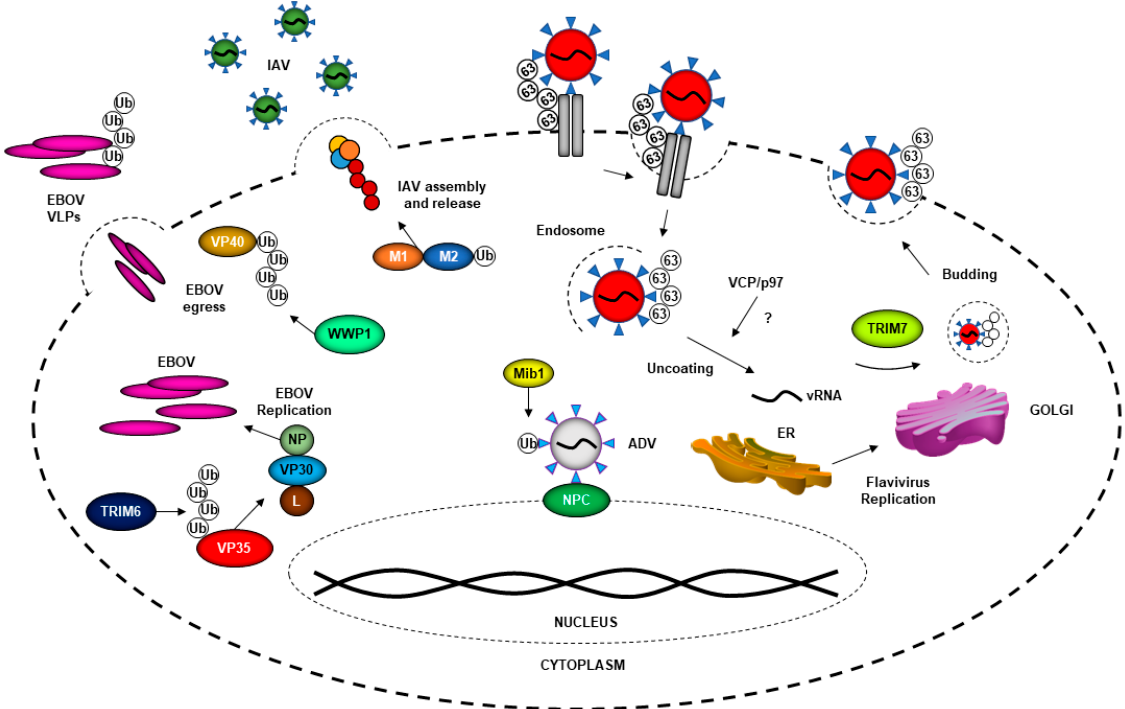
Figure 2. The host ubiquitin system can be hijacked by different viruses at different stages of their life cycles. Entry for flaviviruses like Zika virus (ZIKV) can be enhanced by ubiquitination of the envelope protein. The K63-linked ubiquitin ZIKV brings on its envelope protein allows for greater binding affinity to host receptors, improved cellular entry and higher titers. Adenovirus (ADV) hijacks the E3 ubiquitin ligase Mind bomb-1 (Mib1) to facilitate viral genome uncoating and release at the nuclear pore complex (NPC). Ebola virus (EBOV) can hijack TRIM6 to ubiquitinate VP35 to promote its polymerase cofactor activity and enhance viral replication. Egress of EBOV viral-like particles (VLPs) is enhanced by ubiquitination of EBOV VP40 protein by WWP1 (WW Domain Containing E3 Ubiquitin Protein Ligase 1). The influenza A virus (IAV) M2 protein can be ubiquitinated, allowing for better association with M1 and ultimately improved IAV assembly, budding and release of progeny virions.